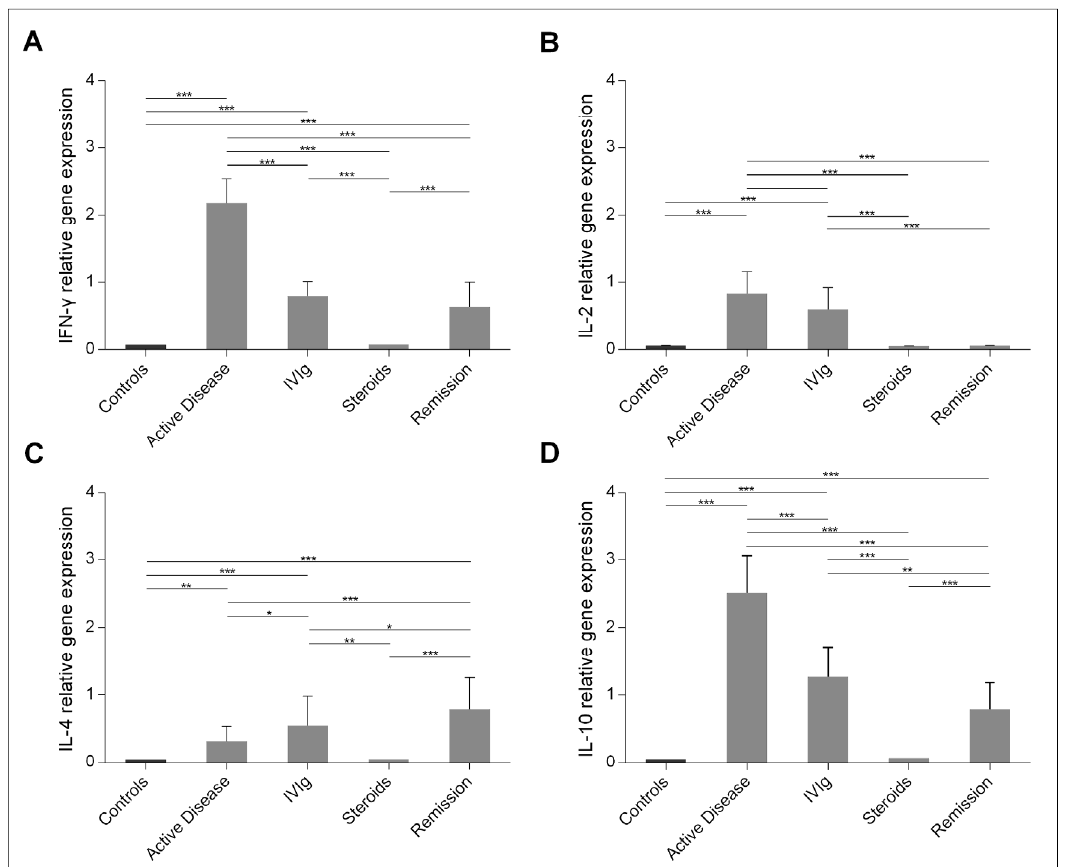
Figure 4. Ex-vivo expression of ( A ) IFN- γ , ( B ) IL-2, ( C ) IL-4 and ( D ) IL-10 in PBMCs isolated from controls and children with ITP in the acute phase, after treatment with IVIg and/or steroids, and in remission. Cytokine gene expression is shown as mean (SD). Asterisks indicate statistical significance (* p < 0.05; ** p < 0.01; *** p < 0.001).